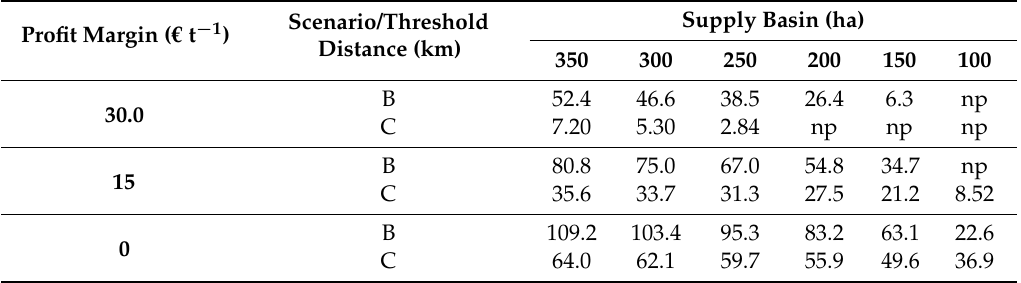
Table 12. Threshold distance of convenience for Scenario A and Scenario B, according to supply basin dimension and expected profit margin.